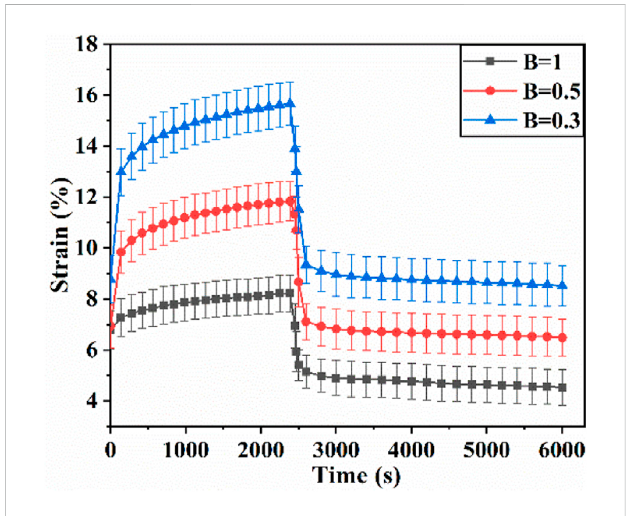
FIGURE 9 Biaxial creep-recovery curves of articular cartilage at different stress ratio.